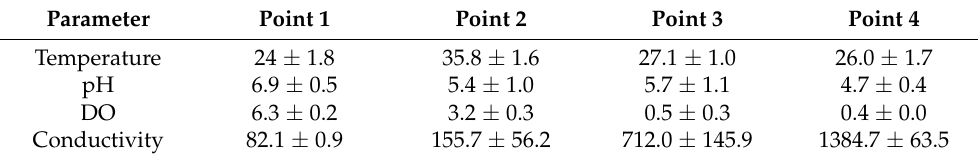
Table 8. Parameter measured in situ along the four sampling points. Mean ± Standard deviation.